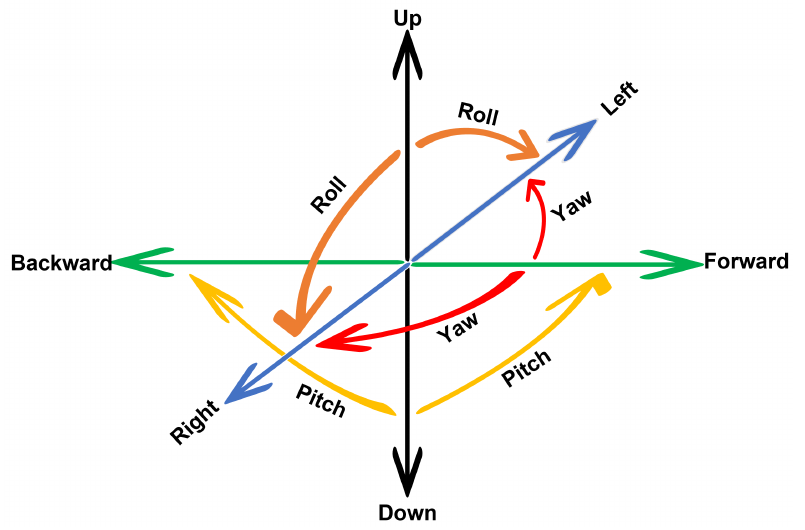
Figure 3. Illustration of six degrees of freedom by yaw, pitch, and roll for UAM attitude